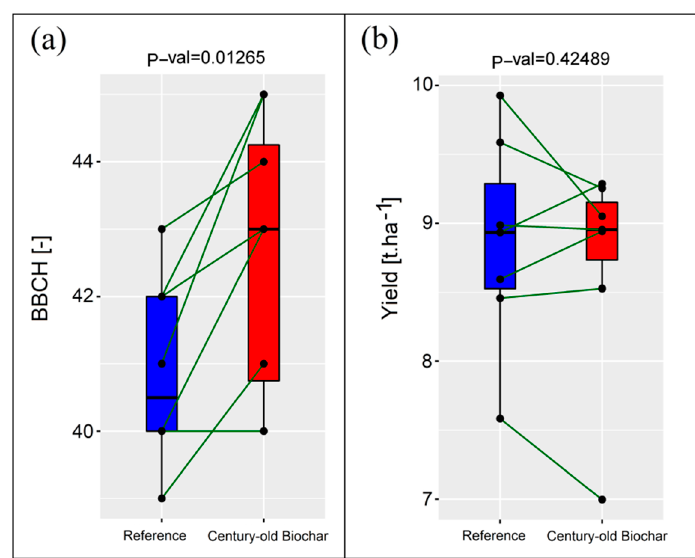
Figure 10. Impact of century-old biochar on ground-based crop traits including crop growth stages, expressed as the biologische bundesanstalt, bundessortenamt and chemical industry (BBCH) scale, on 28 May 2019 ( a ), and yield on 20 July 2019 ( b ). The horizontal black line displays the median value, surrounded by box edges representing the 25th and 75th percentiles. The black circles show the experimental plots of each pair and the dark green lines relate the corresponding reference and century-old biochar plots of each pair.